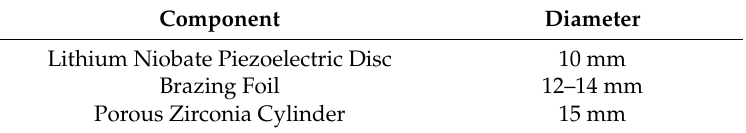
Table 2. Dimensions of relevant components in the brazing evaluation